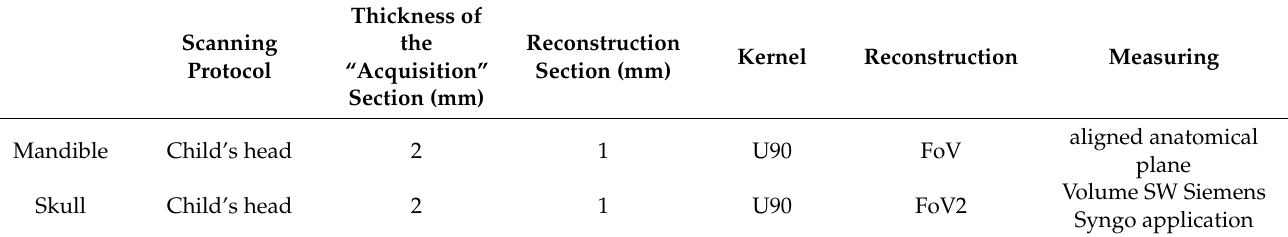
Table 3. CT protocol and